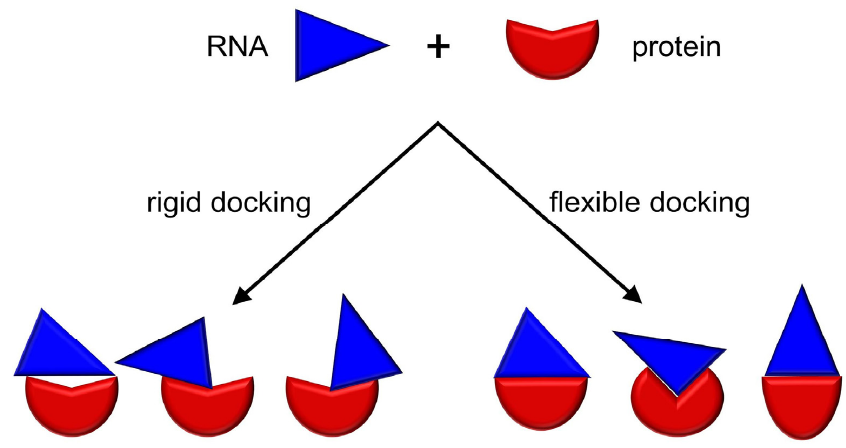
Figure 2. Comparison of rigid and flexible docking methods. A protein and an RNA molecule have been schematically represented as a red and a cyan figure, respectively.